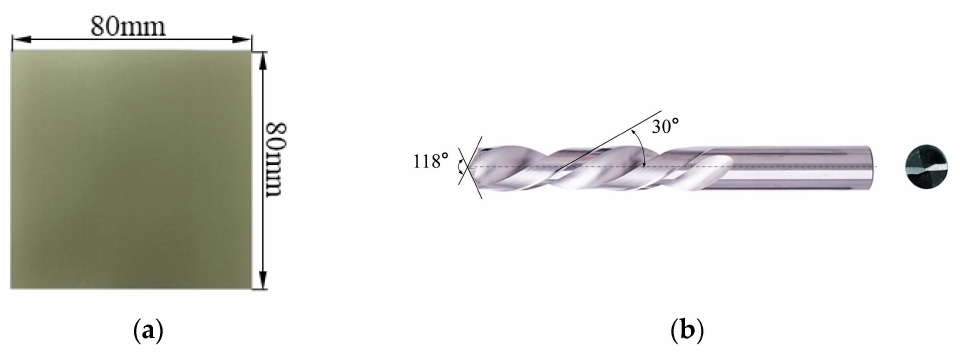
Figure 1. Physical map of workpiece and drill bit. ( a ) Workpiece; ( b ) The integral carbide drill bit.